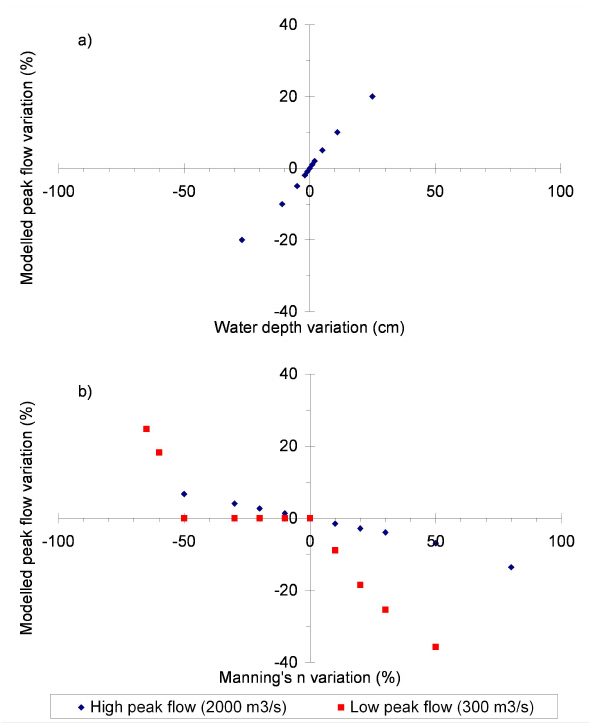
Fig. 9. Results of the sensitivity analyses performed by varying his- torically observed maximum water height (a) and Manning’s n (b) .